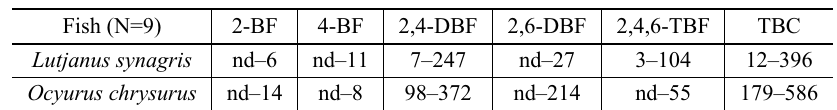
Range of bromophenol concentrations (ng g –1 ) in stomach.